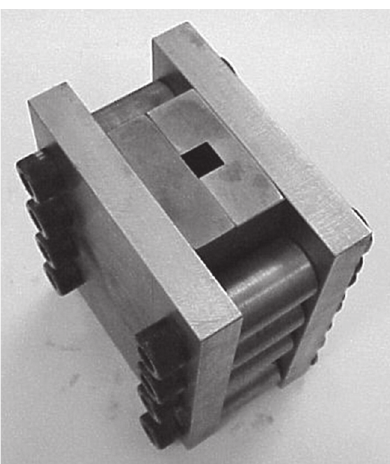
Figure 2. Picture of the ECAP die